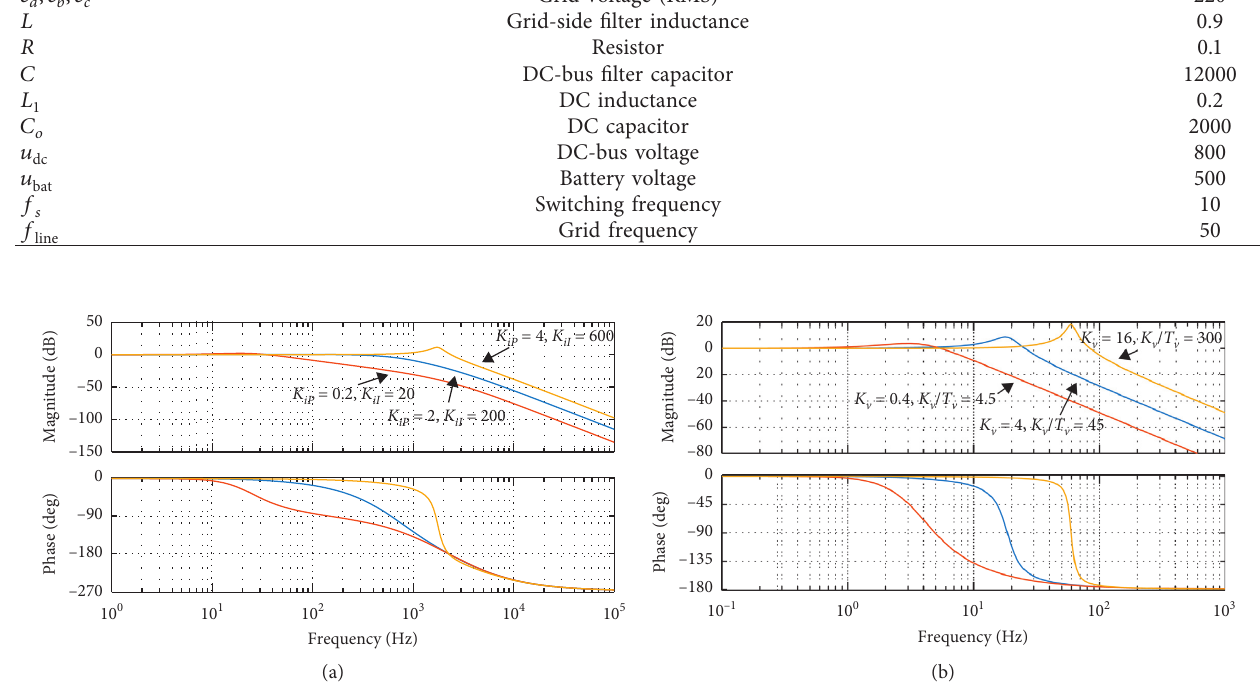
Figure 11: The Bode diagram of system. (a) Bode diagram of current closed loop in the case of different values for the proportional and integration coefficients (21). (b) Bode diagram of voltage closed loop in the case of different values for the proportional and integration coefficients (26).